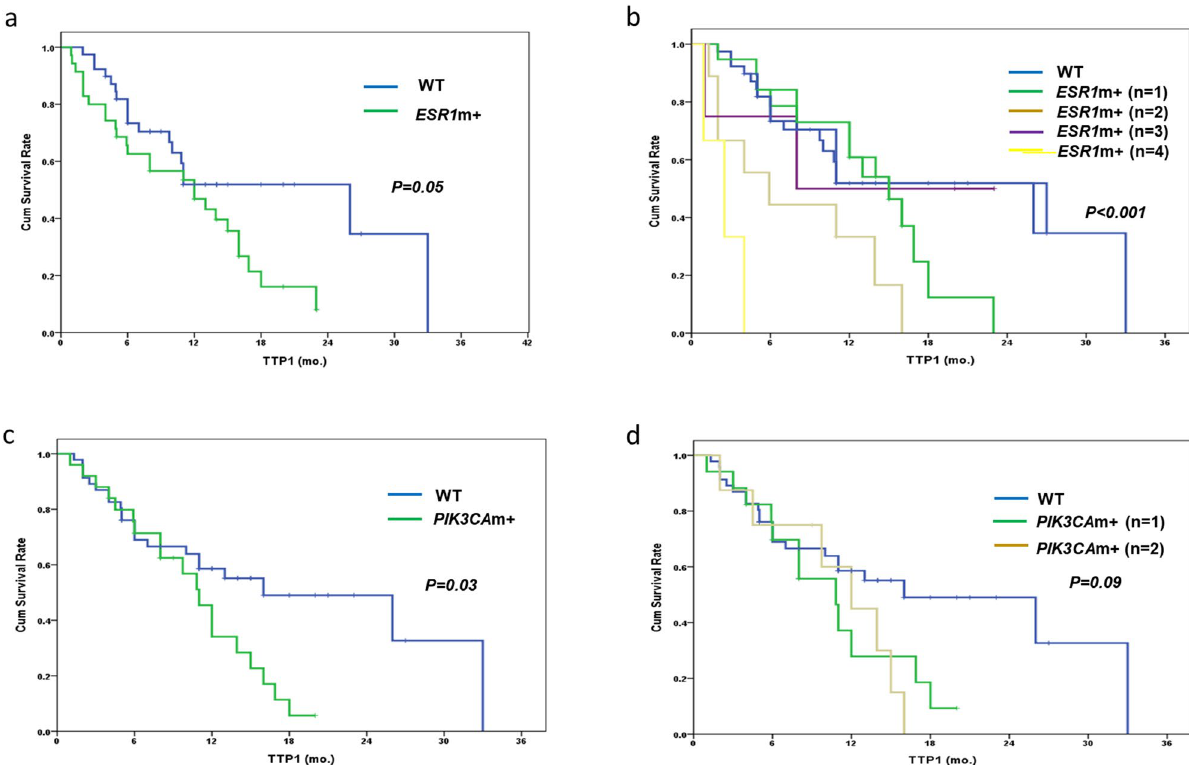
Figure 2. Time to progression after the first ET following enrollment (TTP1) according to the presence of ESR1 and PIK3CA mutations. ( a ) TTP1 according to the presence of ESR1 mutations. ( b ) TTP1 according to the number of ESR1 mutations. ( c ) TTP1 according to the presence of PIK3CA mutations. ( d ) TTP1 according to the number of PIK3CA